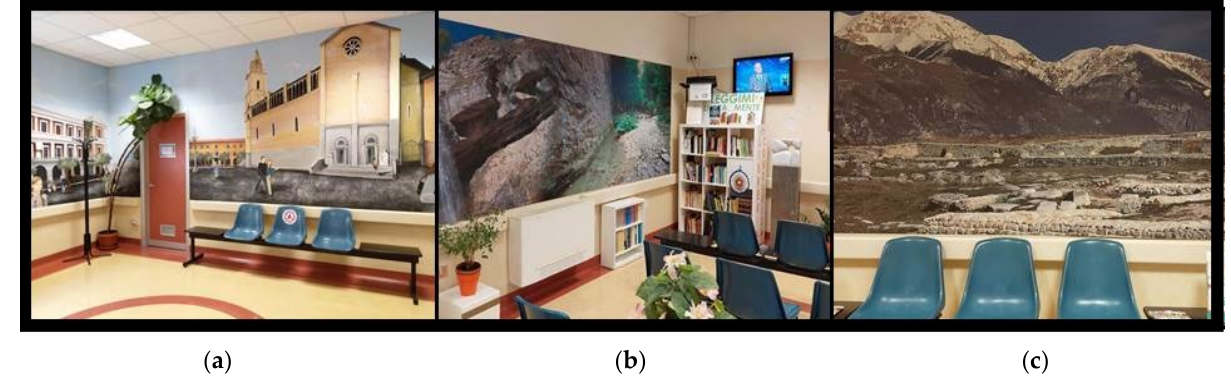
Figure 2. ( a – c ) Examples of environment’ “humanization” in Radiation Oncology Department of